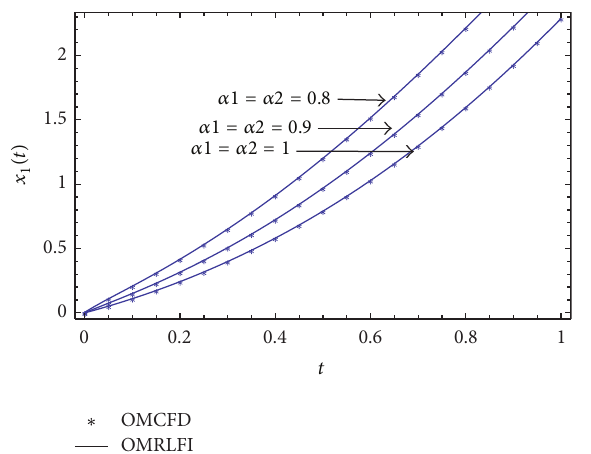
Figure 1: Approximate solutions of 𝑥 1 (𝑡) for 𝑚 = 10 and different values of 𝛼 1 , 𝛼 2 by OMCFD and OMRLFI in Example 12.